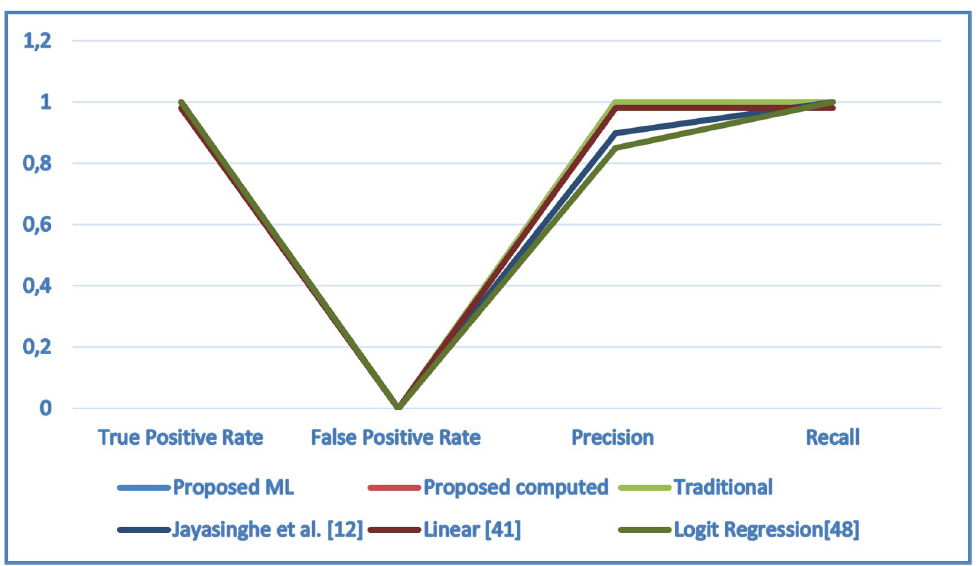
Fig 13. Comparison of proposed approaches to related